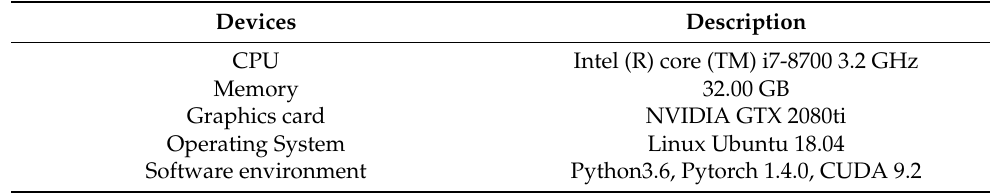
Table 5. Hardware and software of the experimental